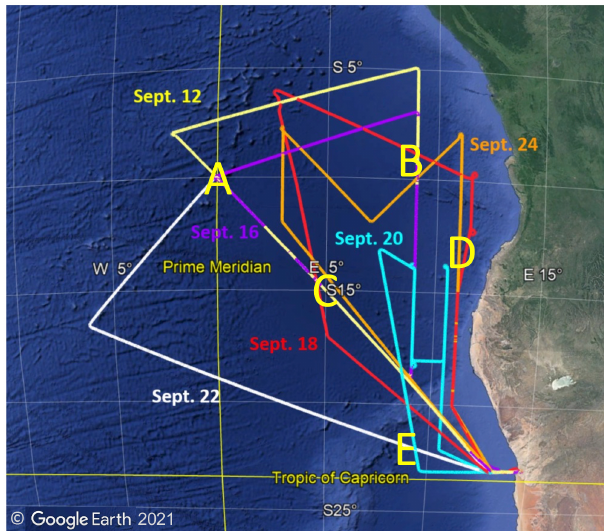
Figure 3. HSRL-2 science data flight tracks during the Septem- ber 2016 IOP. Letters refer to the grid boxes identified in Fig. 2 (© Google Earth).